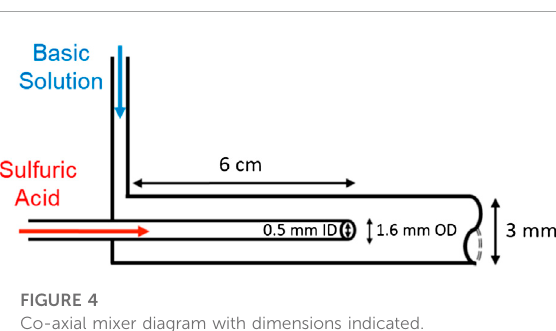
FIGURE 2 Speciation pro fi les for 3,5-dinitrobenzoic acid and ethylenediamine at 25 and 50 ° C. HA and A are the protonated and deprotonated 3,5-dinitrobenzoic acid respectively. BH2, BH and B are the double protonated, single protonated and deprotonated ethylenediamine respectively.